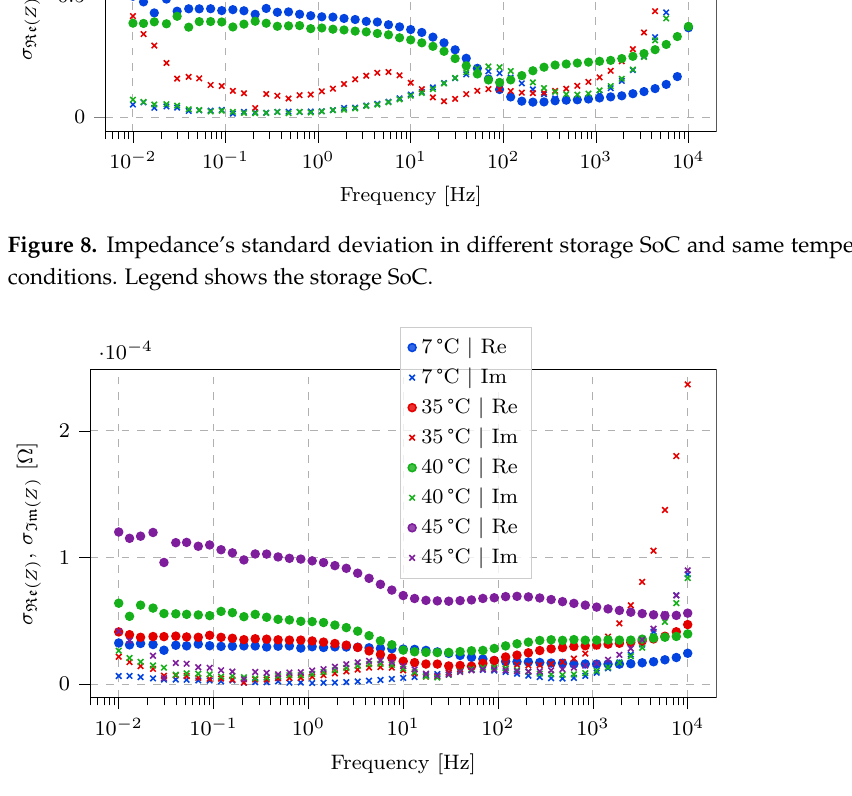
Figure 9. Impedance’s standard deviation in different storage temperature and same SoC ( 50% ) conditions. Legend shows the storage